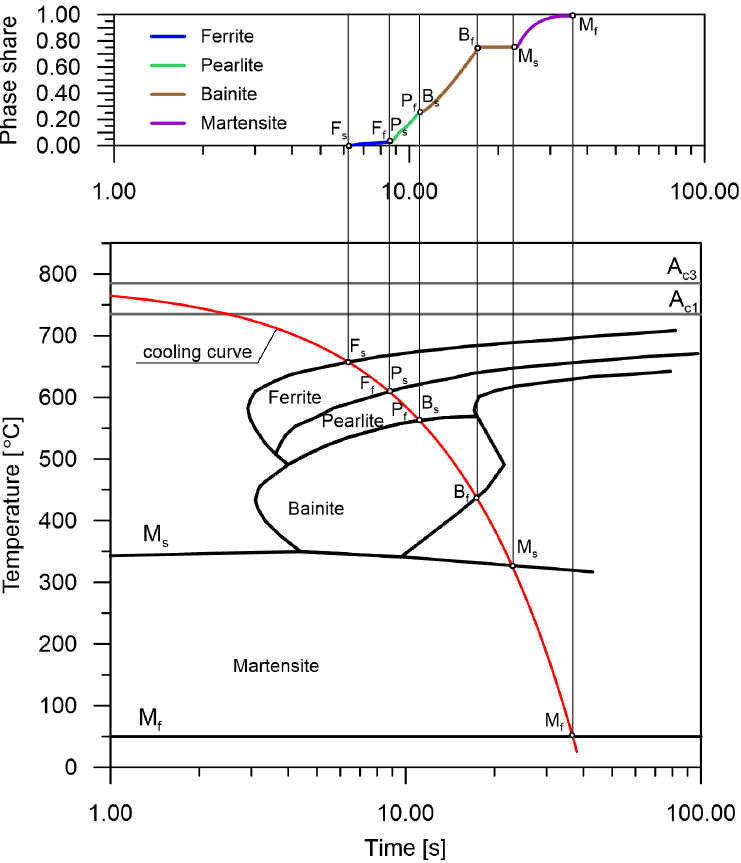
Figure 2. Analyzed diagram of phase transformations in the solid state